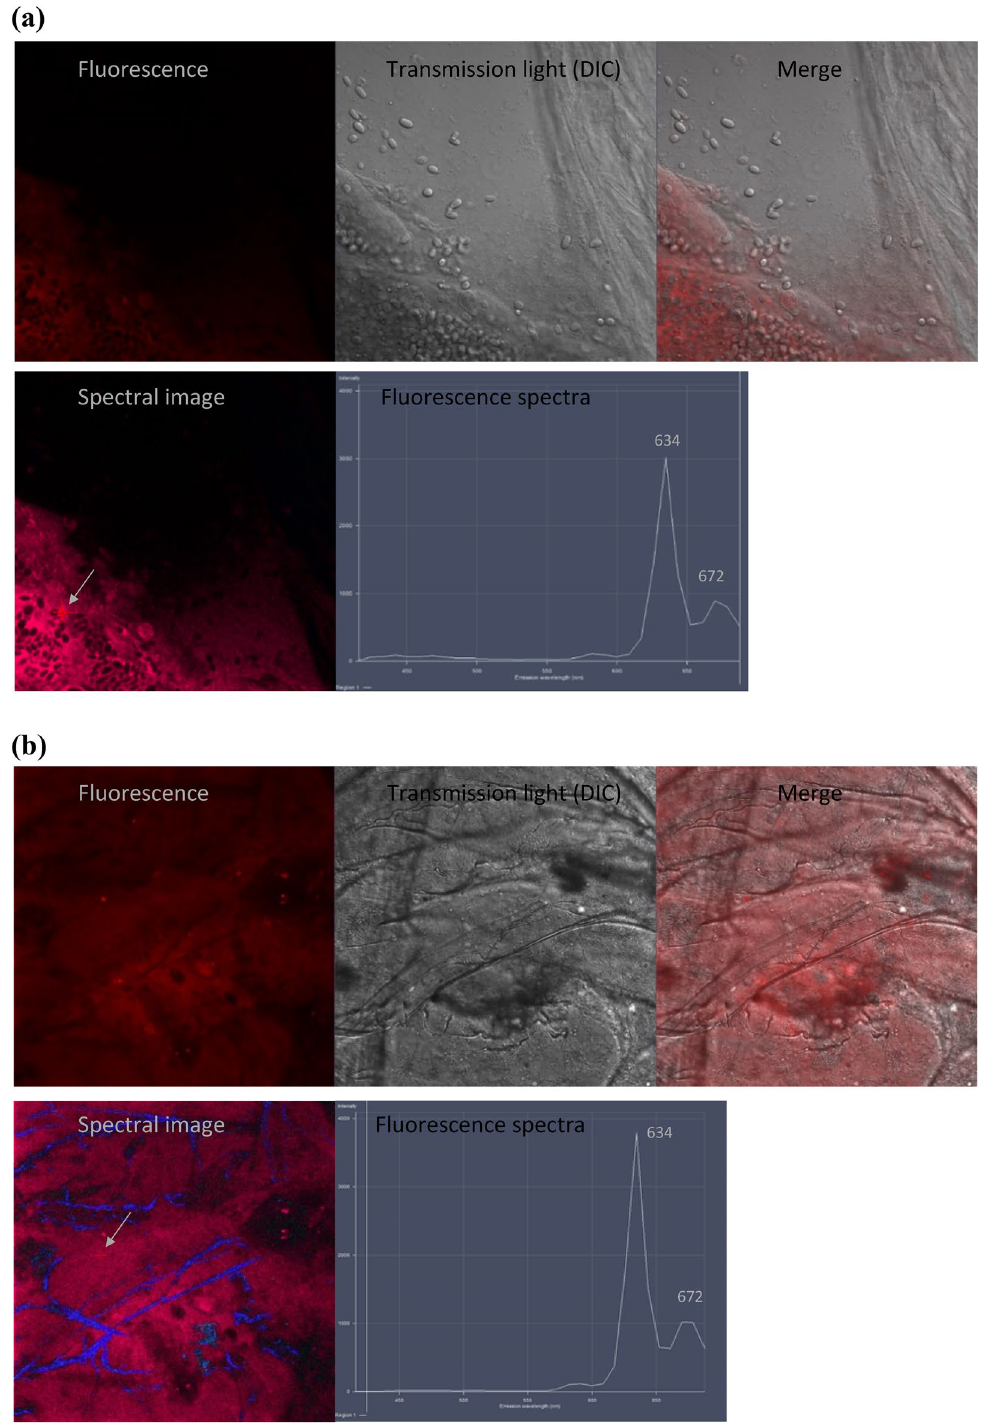
Figure 4. Confocal microscopic images of the midgut segment with porphyrin accumulation in the area of epithelial cells: ( a ) with anchored Nosema ceranae spores in infected honeybees and ( b ) free of N. ceranae spores in non-infected honeybees (λ exc = 405 nm). DIC—differential interference contrast; corresponding fluorescence spectra were collected from the points indicated by